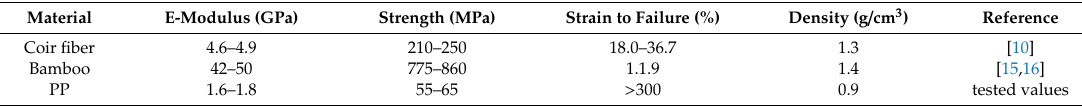
Table 1. Mechanical properties of studied fibers and polymer